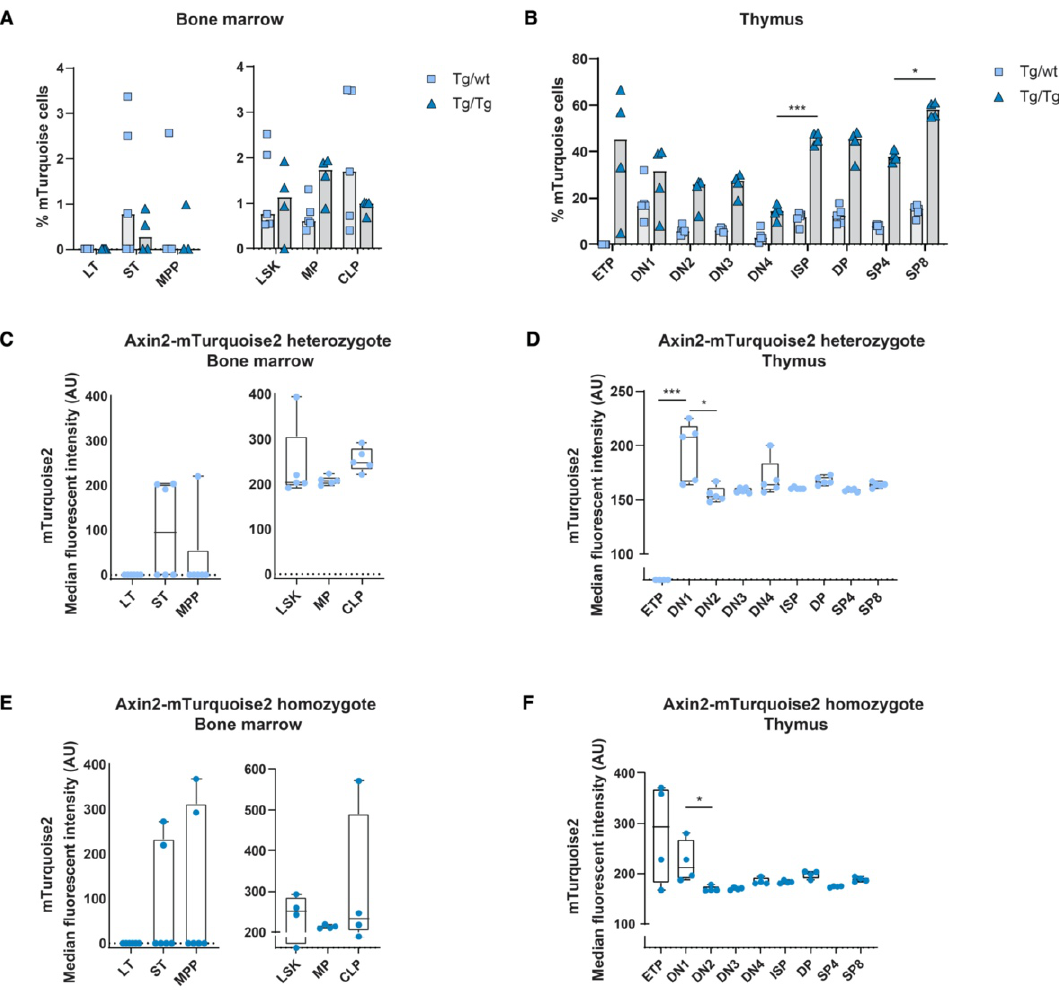
Figure 2. In vivo measurement of canonical Wnt signaling activity throughout hematopoietic development. Activation of the canonical Wnt signaling pathway was measured by FACS using steady-state Axin2-mTurquoise2 reporter mice. Quantification of the frequency of mTurquoise2 ( A , B ) and the median fluorescence intensity (MFI) of the mTurquoise2 populations of heterozygous Axin2-mTurquoise2 (Tg/wt) ( C , D ) and homozygous Axin2-mTurquoise2 mice (Tg/Tg) ( E , F ) for each subset in the bone marrow ( A , C , E ) and in the thymus ( B , D , F ). Littermate mice not carrying the reporter transgene (Axin2-mTurquoise2 wild type) were used to define the mTurquoise2 negative population. Data represent results for five heterozygous Axin2-mTurquoise2 mice (Tg/wt) and four homozygous Axin2-mTurquoise2 mice (Tg/Tg) from two independent experiments. Data bars represent median values. Error bars represent minimum and maximum values. * p< 0.033 and *** p < 0.001 (ANOVA test).